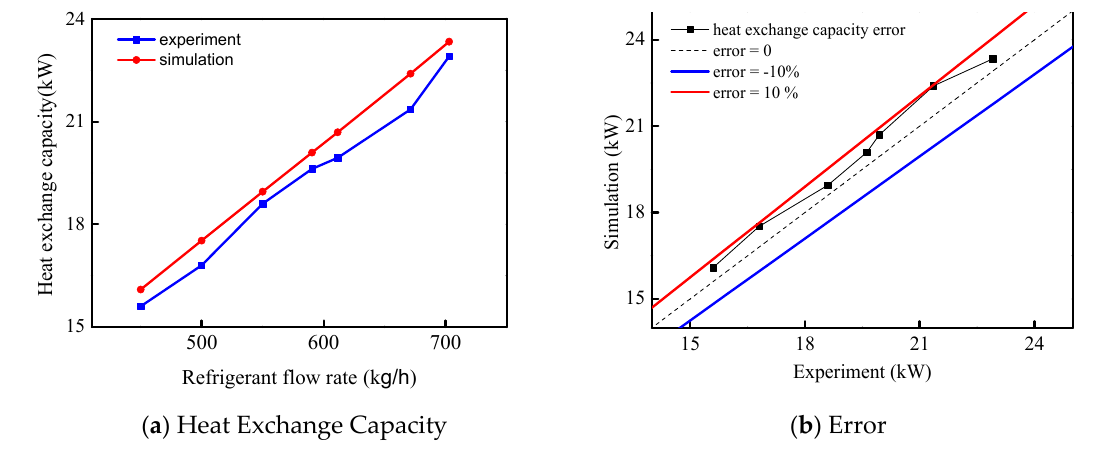
Figure 10. Simulation and experimental data comparison of evaporator.